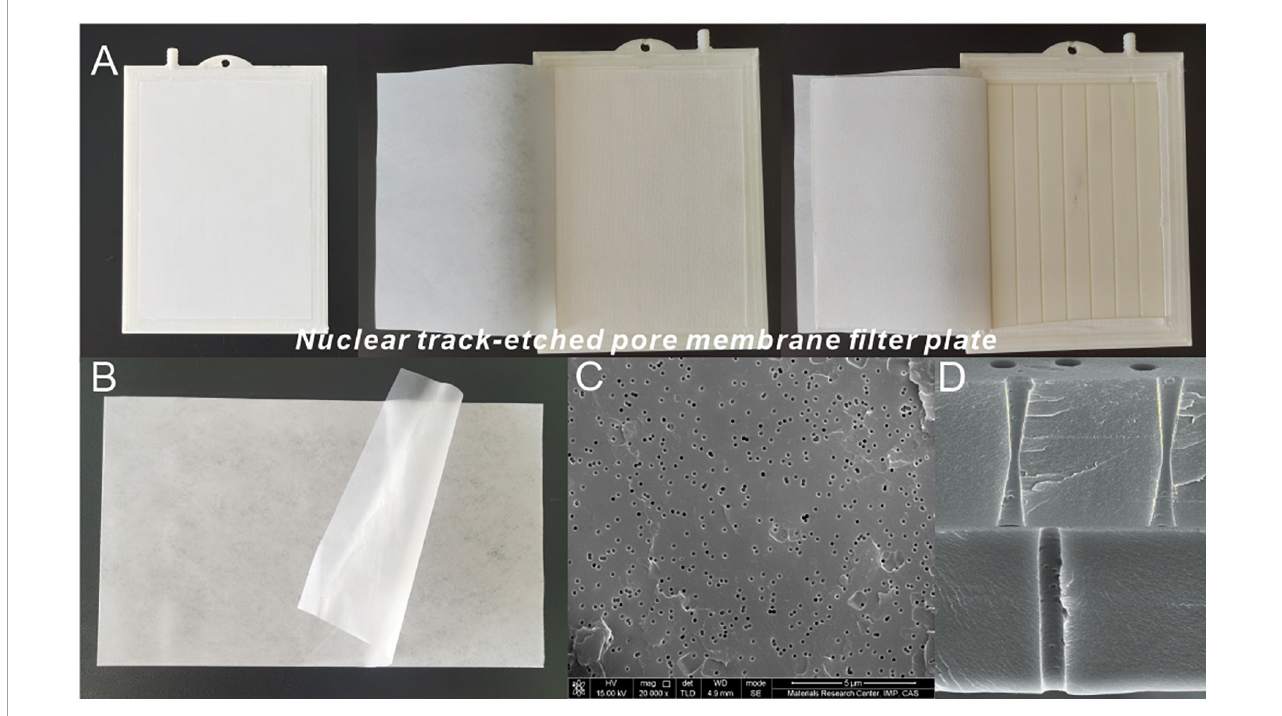
FIGURE1 Ionic membrane and ionic membrane filtration machine. (A) Ionic membrane filter plate. (B) Ionic membrane element. (C) Scanning electron microscope (SEM) images of the ionic membrane from Modan’s article (Mo et al., 2014). (D) Cross sections of Positron Emission Tomography (PET) with pores displaying double cone shape and cylindrical shape from Modan’s article (Mo et al.,